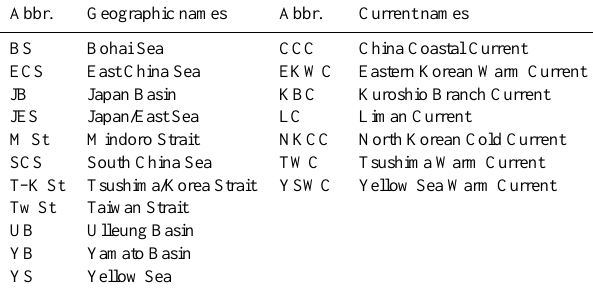
Table 1. List of abbreviations of geographic names and currents.